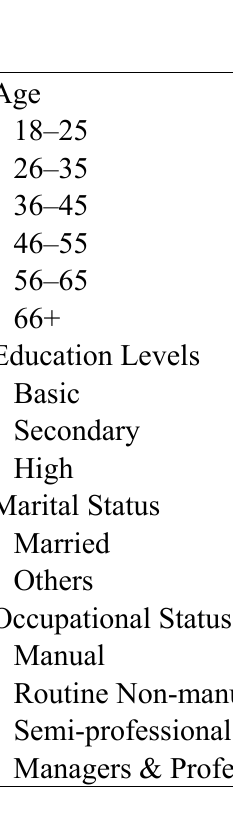
Table 4. Logistic Regression Models on the Likelihood of Being Overweight (Odd Ratios (OR) and their 95% Confidence Intervals (CI) in